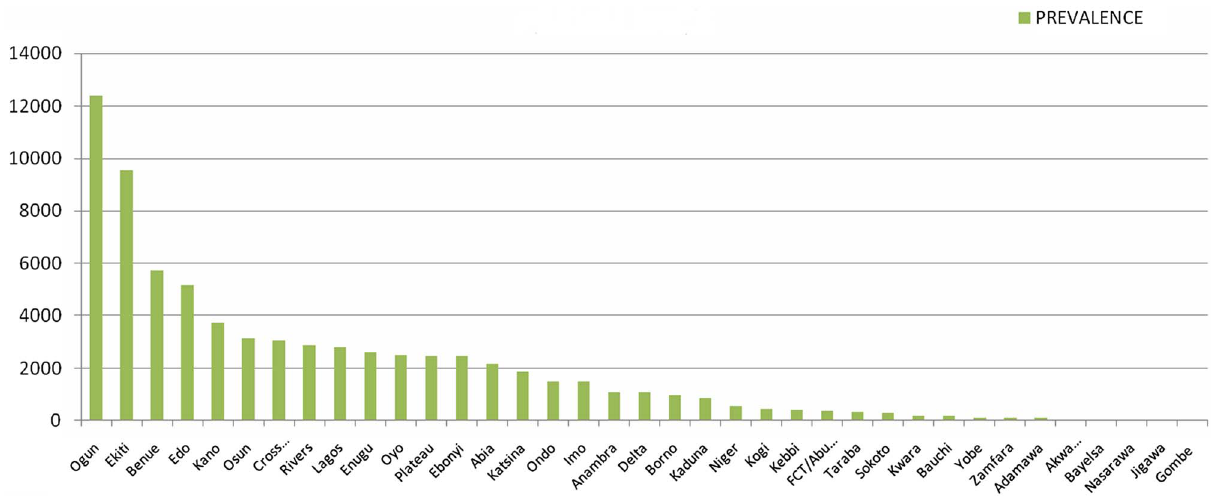
Figure 2. Summary of the prevalence of Schistosoma haematobium across the 36 states of Nigeria including